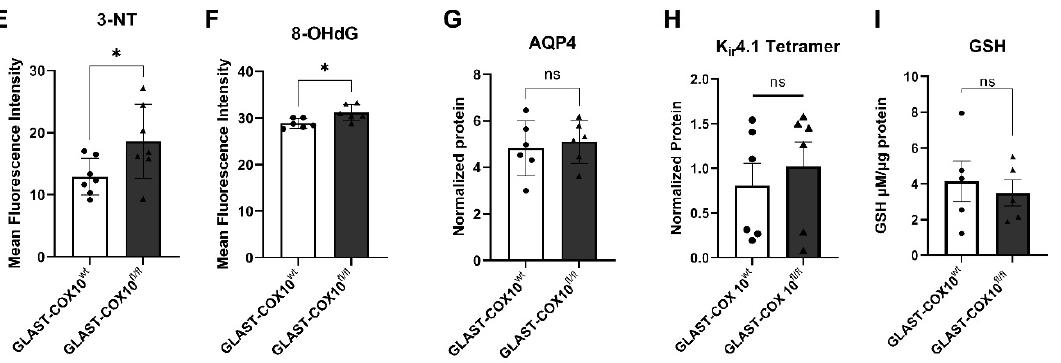
Figure 3. Expression of oxidative stress markers and glutathione in control and GLAST-COX10 fl/fl retinas. Immunolabeling for ( A ) 3-nitrotyrosine (3NT), a marker for protein nitrosylation shows greater 3NT label in the IPL of GLAST-COX10 fl/fl retina, and a shift of 3NT into the MG endfeet of GLAST-COX10 fl/fl retina from its primary location in retinal ganglion cells in the wildtype retina (white arrows). ( B ) Immunolabeling for 8OHdG, a marker of nucleic acid oxidation, illustrates an increase in labeling intensity in the ganglion cell layer (GCL) (white arrowheads), as well as in MG processes of GLAST-COX10 fl/fl retinas (white arrows). ( C ) Immunofluorescence of aquaporin-4 (Aqp4; green immunolabel) was not appreciably altered in the GLAST-COX10 fl/fl retina as compared to the wildtype. ( D ) Immunohistochemical analysis of K ir 4.1 in retinal cross-sections showed no differences between control and GLAST-COX10 fl/fl retinas. ( E ) Quantification of 3-NT immunolabeling in retinal cross sections. GLAST-COX10 fl/fl retina had significantly higher 3-NT fluorescence compared to control retina (* p = 0.0419). ( F ) Quantification of 8OHdG immunolabeling in retinal cross sections. GLAST-COX10 fl/fl retina had significantly higher 8OHdG fluorescence compared to control retina (* p = 0.0177). ( G ) Quantification of Aqp4 protein from wildtype and GLAST-COX10 fl/fl retina. There was no statistical difference across the groups for Aqp4. ( H ) Quantification of K ir 4.1 protein from wildtype and GLAST-COX10 fl/fl retina. There was no statistical difference across the groups for the tetrameric protein, or the trimeric protein, see Figure S6. ( I ) Total retinal glutathione (GSH) concentrations between wildtype and GLAST-COX10 fl/fl retinas were not statistically different. For panels E through I, error bars represent mean ± SEM GCL = ganglion cell layer; INL = inner nuclear layer; ONL = outer nuclear layer. Scale bars: 25 µ